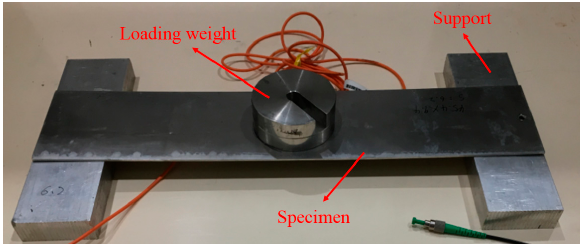
Figure 10. Experimental setup of loading tests.